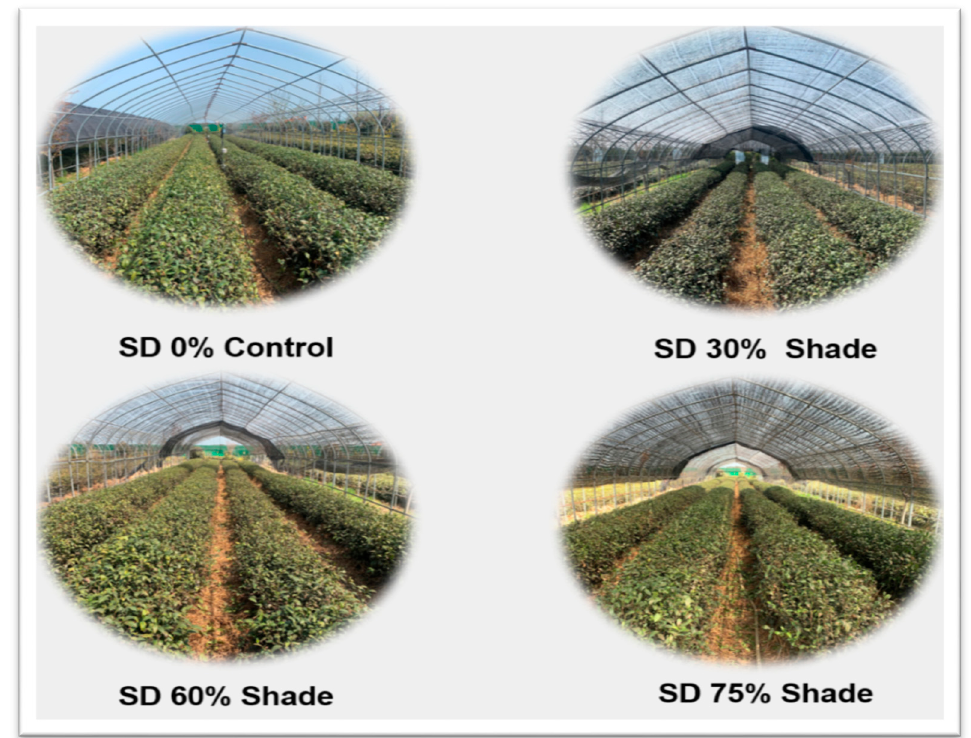
Figure 1. Effects of shading nets on tea cultivar C. sinensis cv. “Zhong Cha 102” under different climatic conditions.